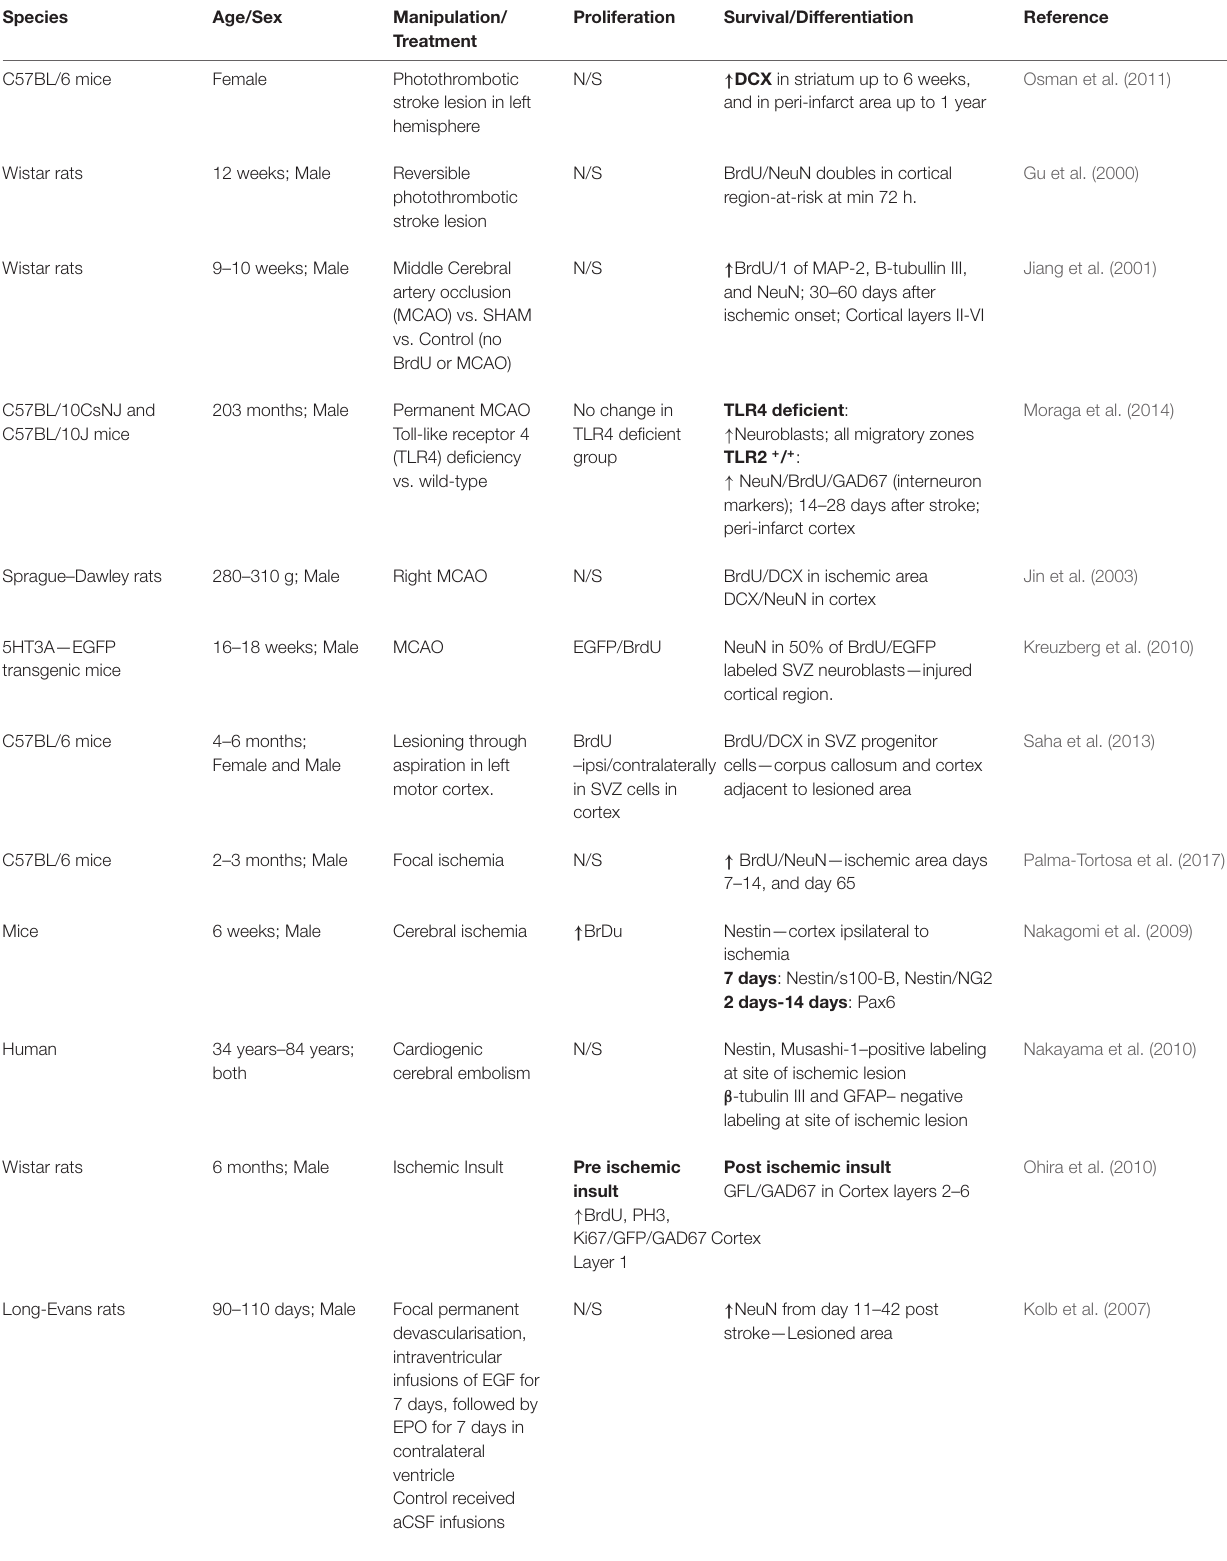
TABLE 3 | Summary of studies investigating neurogenesis in the